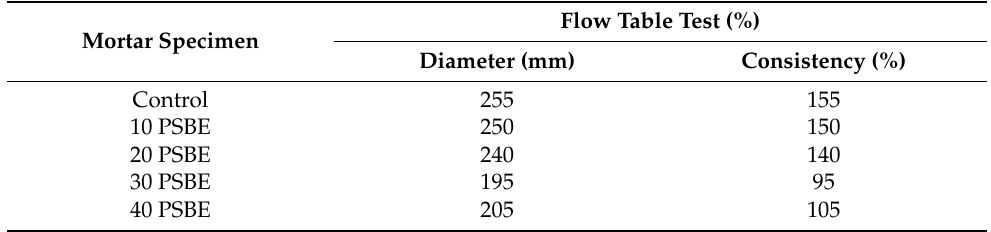
Table 4. Flow table test results.